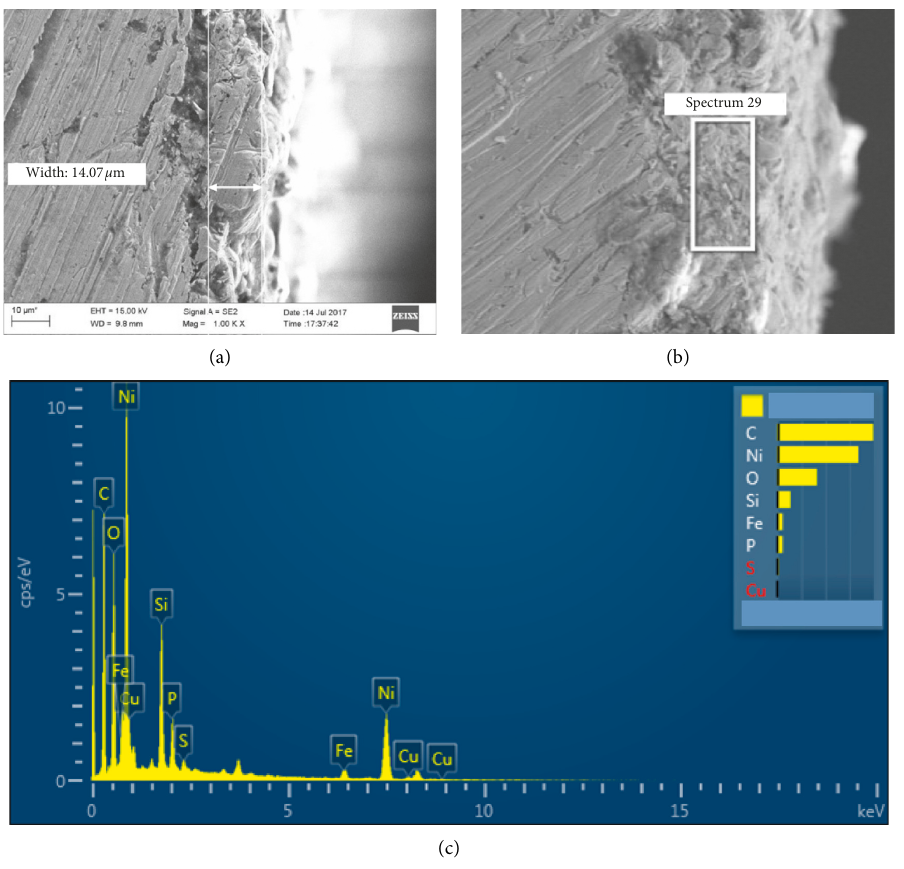
Figure 5: SEM image of the copper tool with diamond-nickel coating. (a) Thickness image of the composite tool. (b) Local image of the composite tool. (c) Local energy spectrum analysis of the copper tool.